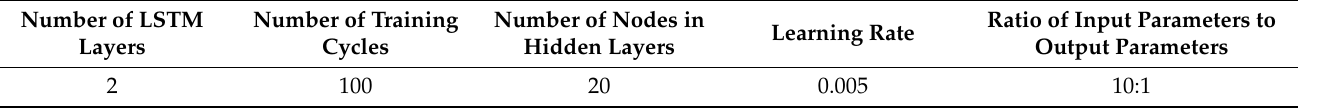
Table 2. BiLSTM initialization parameter